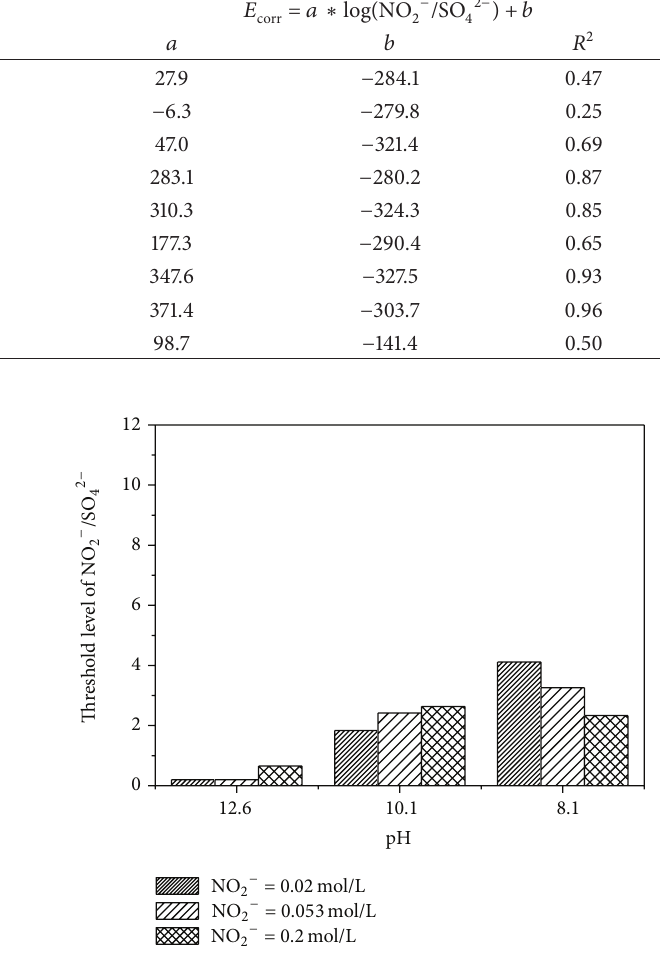
Figure 8: Effect of NO 2− on the threshold values of NO 2− /Cl − . Figure 9: Effect of NO 2− on the threshold values of NO 2− /SO 42− .